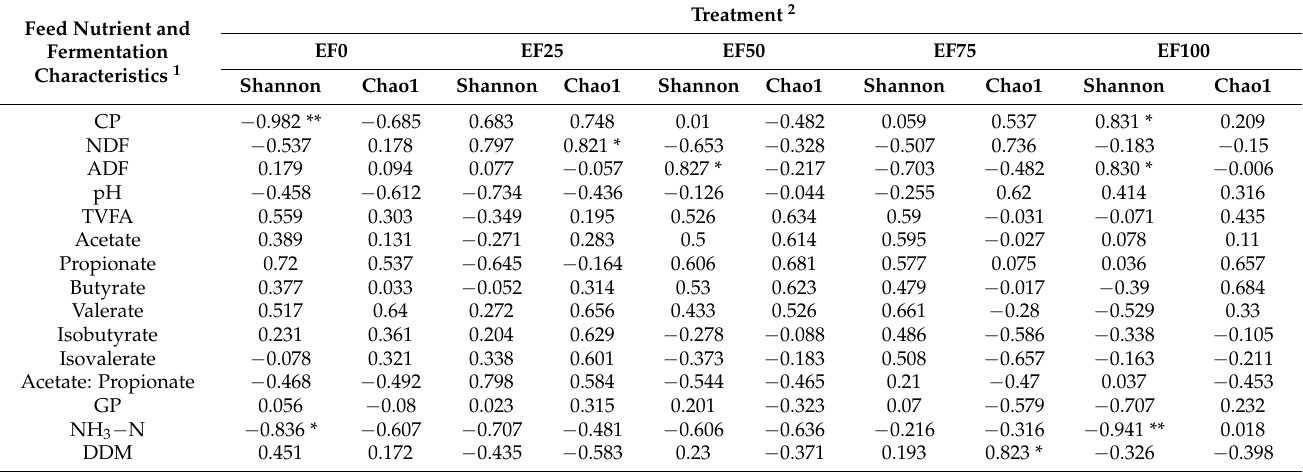
Table 6. Spearman correlations of alpha diversity to feed nutrient and fermentation parameters in sheep rumen fermentation medium with different replacement ratio levels of endophyte-free Achnatherum inebrians